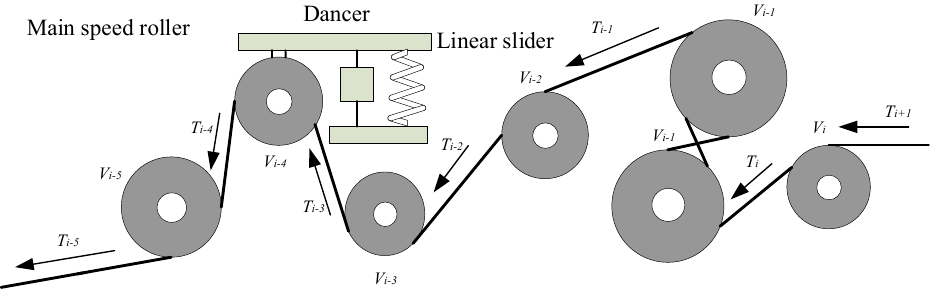
Figure 5. Cross-section view of the main speed roller.